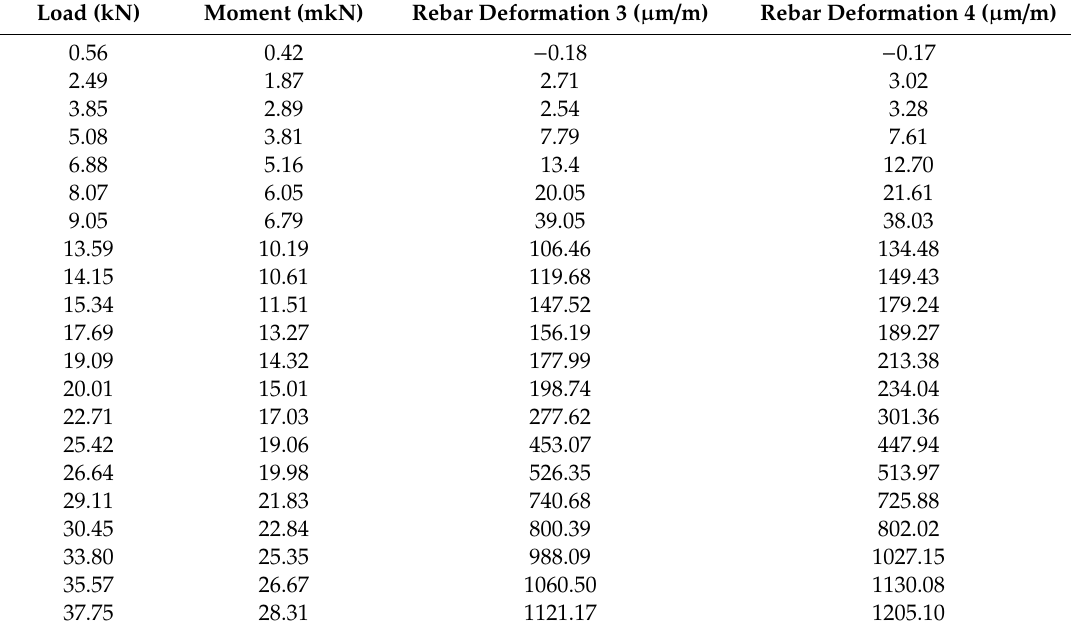
Table 1. Relation between loads applied and deformation of the rebars 3 and 4.